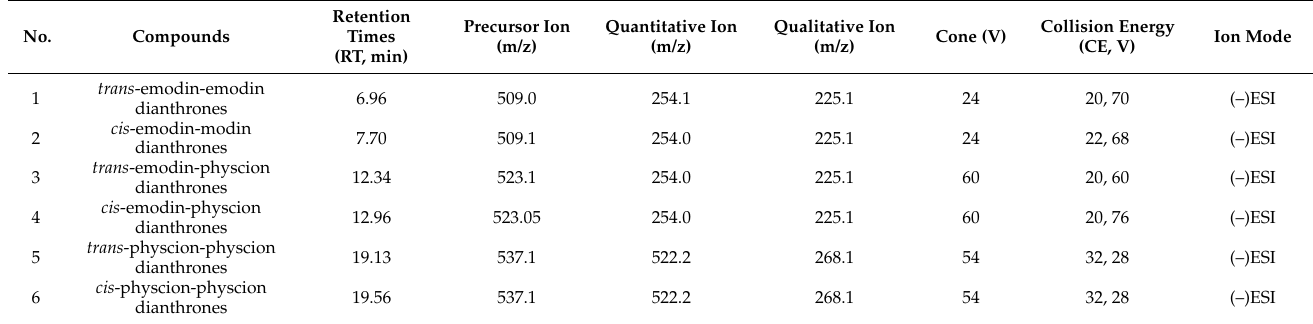
Table 6. Parameters of 6 dianthrones in multiple reaction monitoring (MRM)